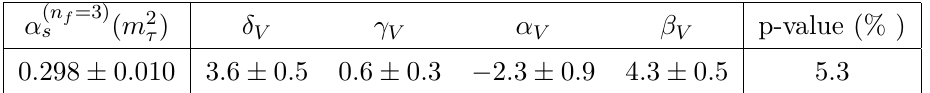
Table 4 . Fitted values of α ( n f =3) s ( m 2 with the default choice (4.3).